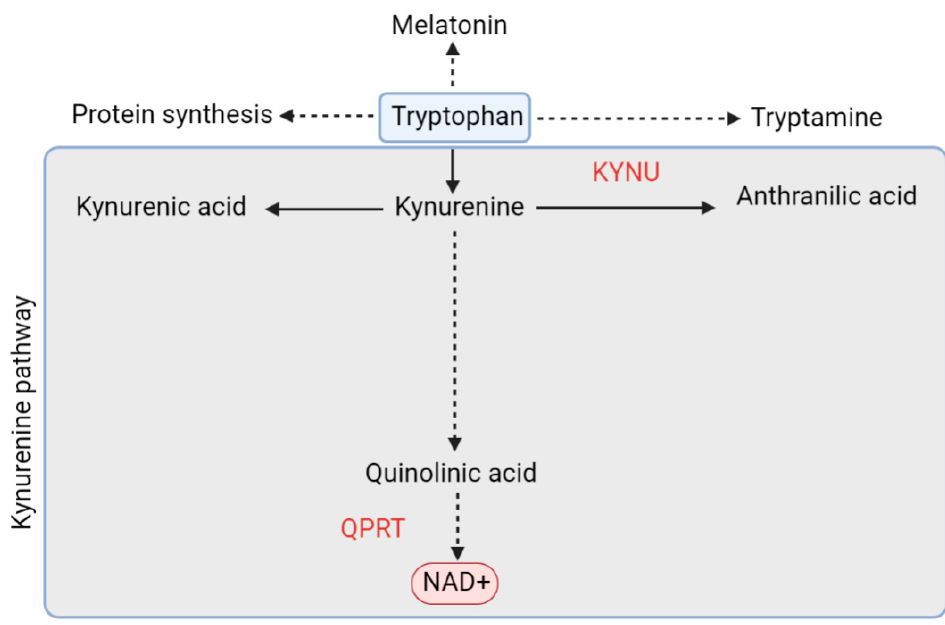
Figure 3. Simplified overview of the kynurenine pathway of tryptophan metabolism. Key enzymes are shown in red: kynureninase (KYNU); quinolinic acid phosphoribosyltransferase (QPRT).